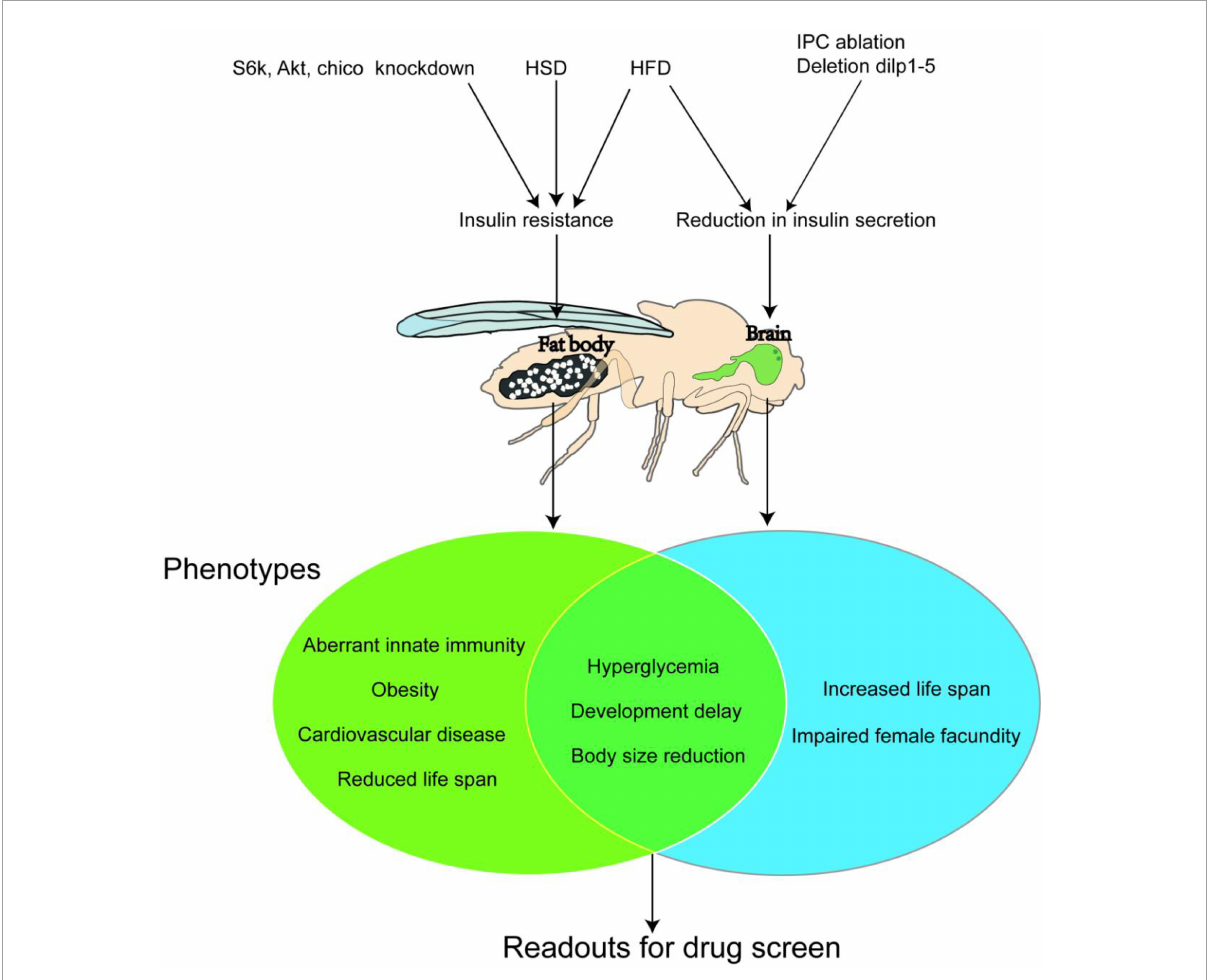
FIGURE2 Three classic Drosophila Diabetes Models. A high sugar diet (HSD) and High-fat diet (HFD) affect the nutrient metabolism in both larvae and adult bodies (especially the fat body) of fruit flies and induce insulin resistance, which causes type 2 diabetes. While ablation of the insulin-produced cells (I) or knockdown of the expression of insulin-like peptides ( dlips ) in their brain abolish the secretion of DLIPs, thus building a type 1 diabetes model. The Venn diagram presents the symptoms (or phenotypes) of the type 2 diabetes model and type 1 diabetes models of the fruit fly. Both models show common marks, such as hyperglycemia, developmental delaying, and growth retardation. Such marks could be used as trails for pharmacodynamics evaluation during large-scale new anti-diabetic compounds